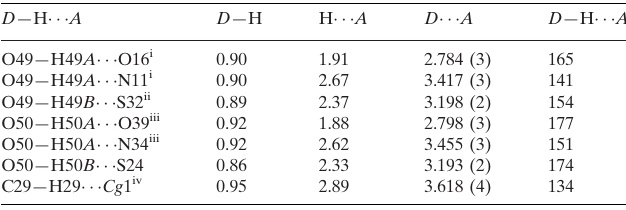
Hydrogen-bond geometry (A˚ , (cid:5) ). Cg 1 is the centroid of the N34/C33–C35